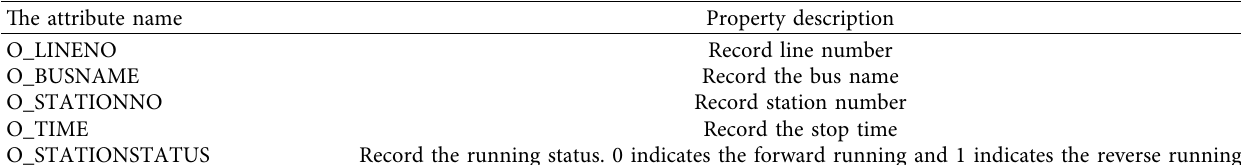
Table 1: The attribute of AVL data.